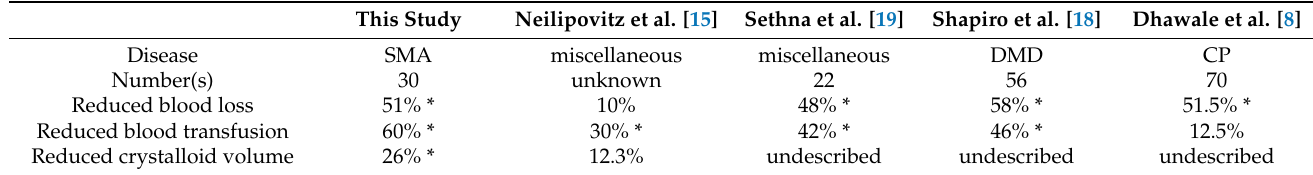
Table 4. Tranexamic acid-treated patients with neuromuscular scoliosis reported in previous studies and this